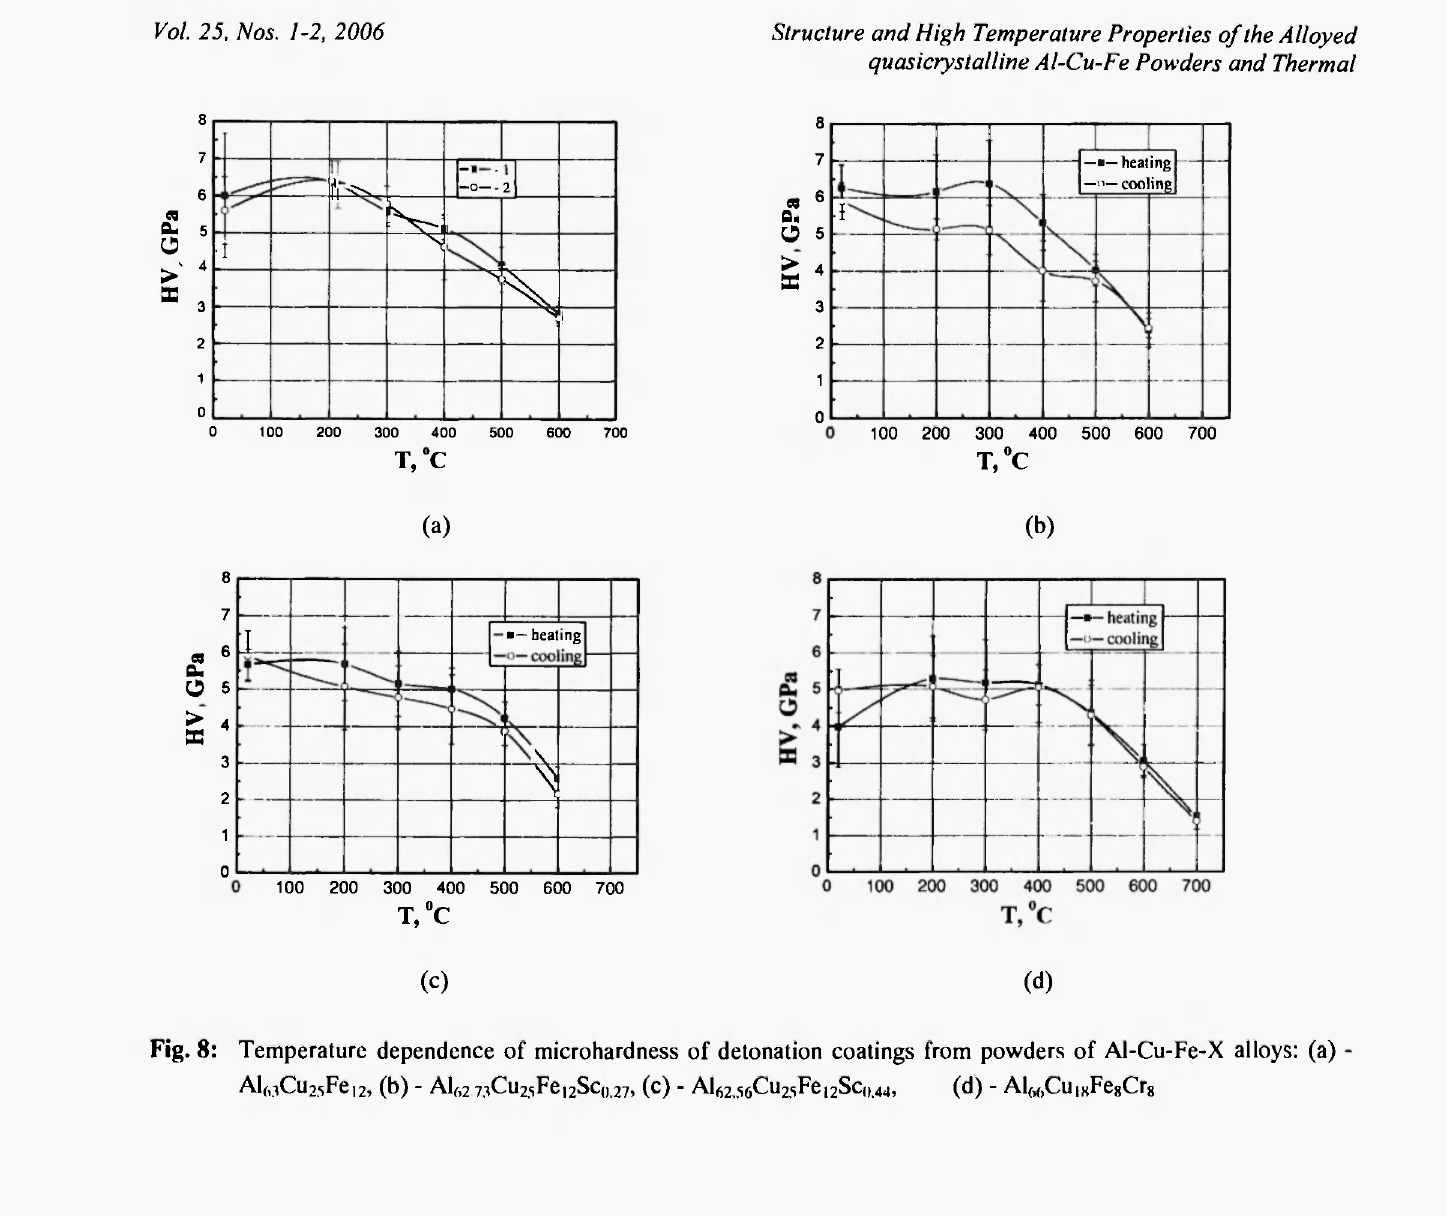
Fig. 8: Temperature dependence of microhardness of detonation coatings from powders of Al-Cu-Fe-X alloys: (a) Alf.3Cu2.sFei2, (b) - Al 62 „Cu 2s Fe l2 Sc (l . 27 , (c) - Al fi2 , sfl Cu 2s Fei 2 Sc ( ,. 4 4, (d) - Al w ,Cui K Fe R Cr